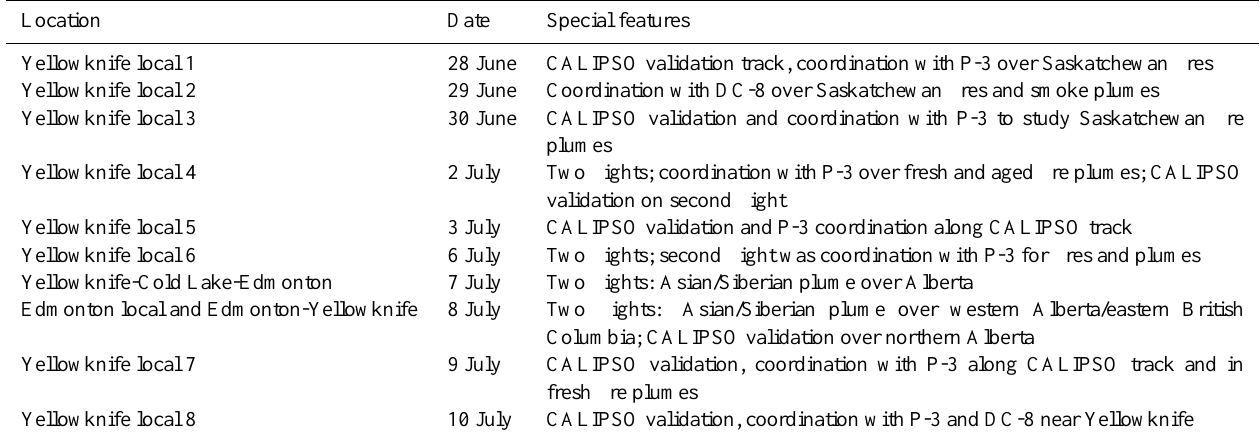
Table 5c. B-200 flights during the ARCTAS-B summer deployment 1